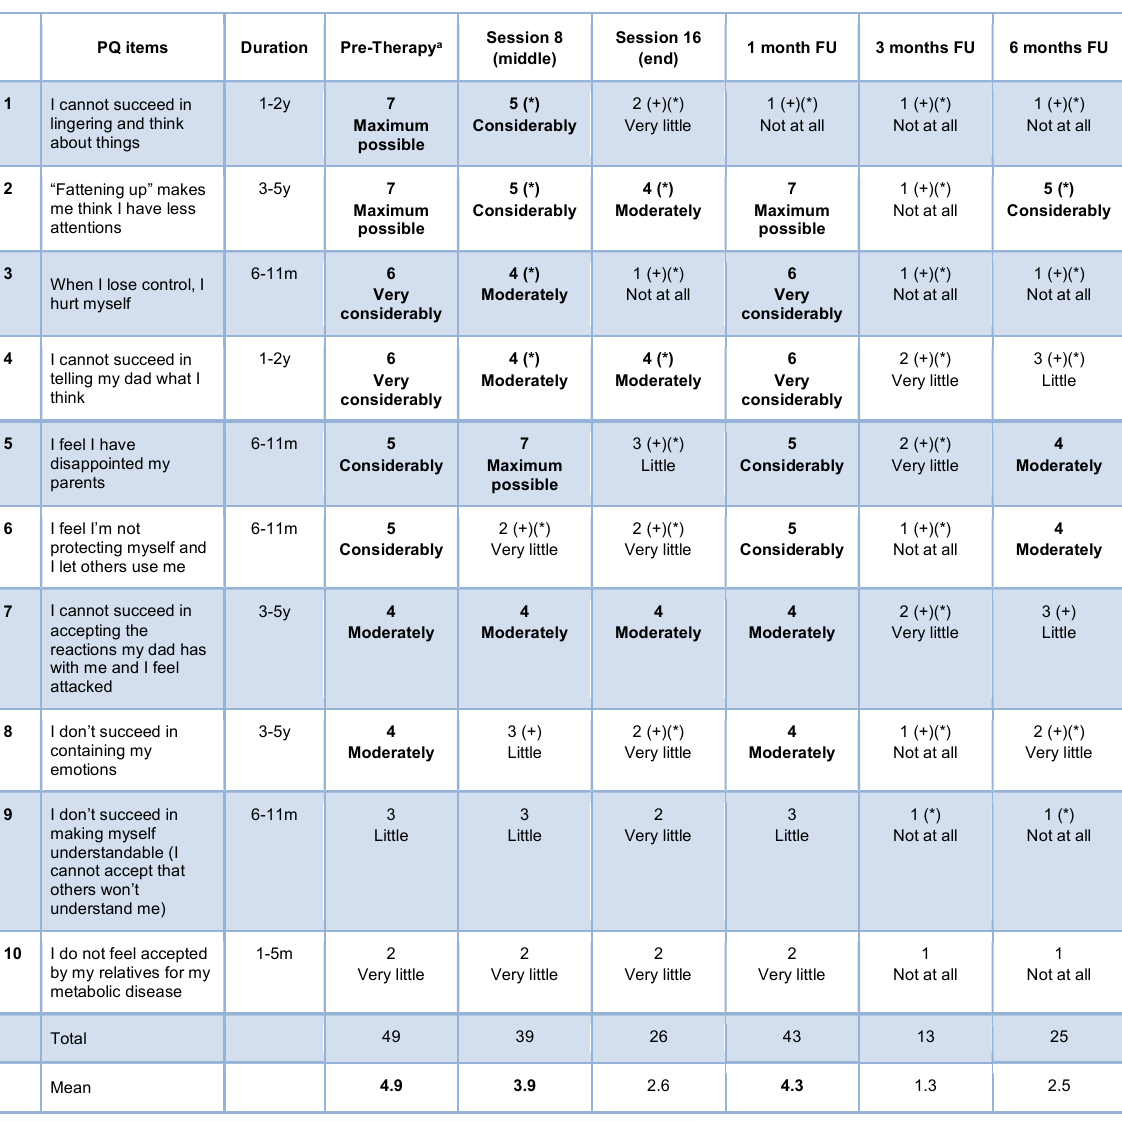
Table 2: Deborah’s personal problems (PQ), duration and scores Note: Values in bold are within clinical range. PQ = Personal Questionnaire (Elliott, Shapiro, & Mack, 1999). Clinical cut-off point: PQ ≥3. Reliable Change: PQ improvement of two points. +=indicates clinically significant change (CS). *=indicates reliable change (RC). The rating is on a scale from 1 to 7 and indicate how much each problem has bothered the client: 1 = not at all; 7 = maximum. m